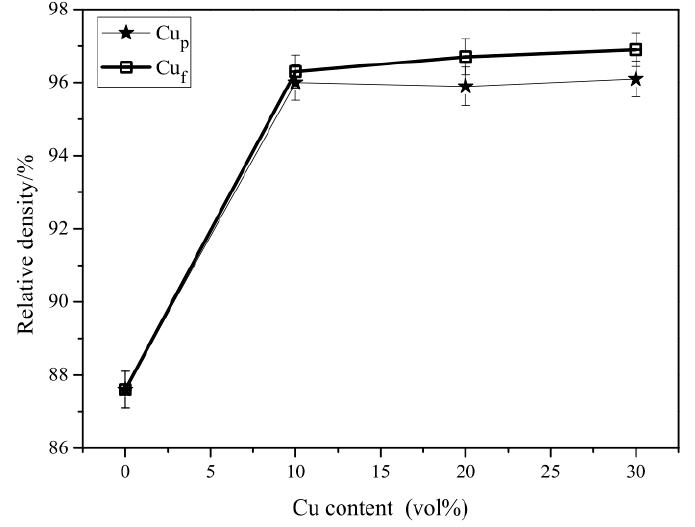
Figure 2. Relative density of Al 2 O 3 /30galss/Cu as a function of Cu content.